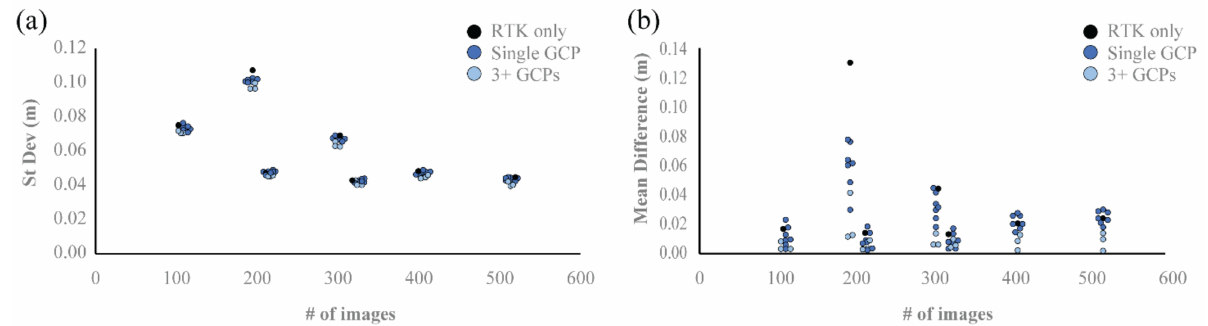
Figure 6. M3C2 error (y-axis) as a function of number of images used in UAV-SfM processing. ( a ) standard deviation of errors; ( b ) mean error. Black points represent results for RTK-only DG (no GCPs) and lightest blue use >3